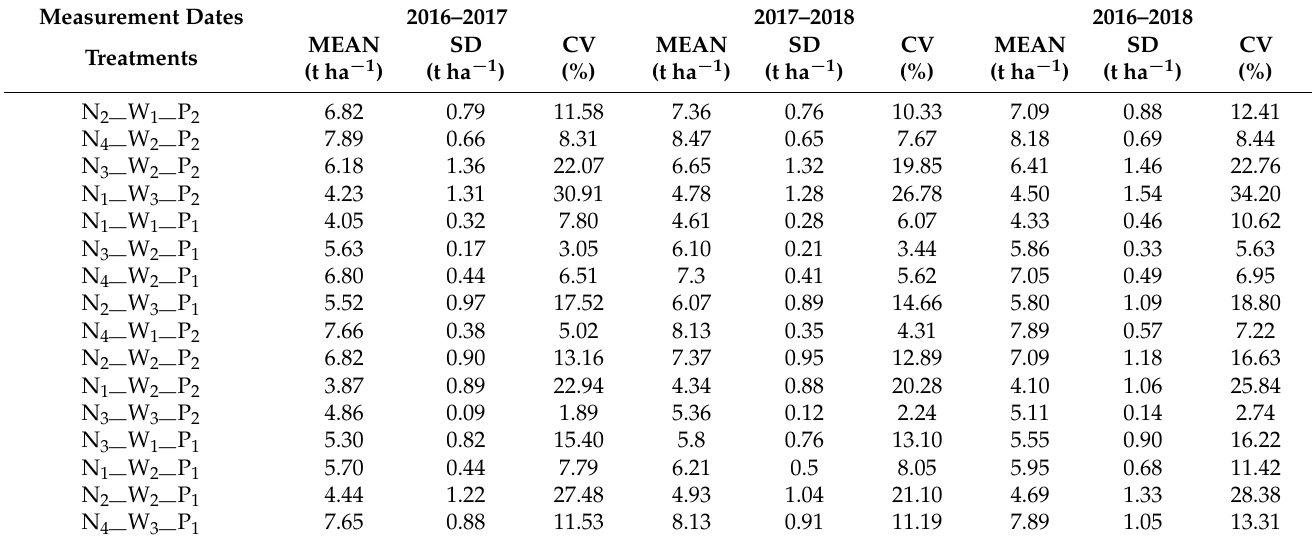
Table A2. Main statistical parameters of grain yield under different treatments.